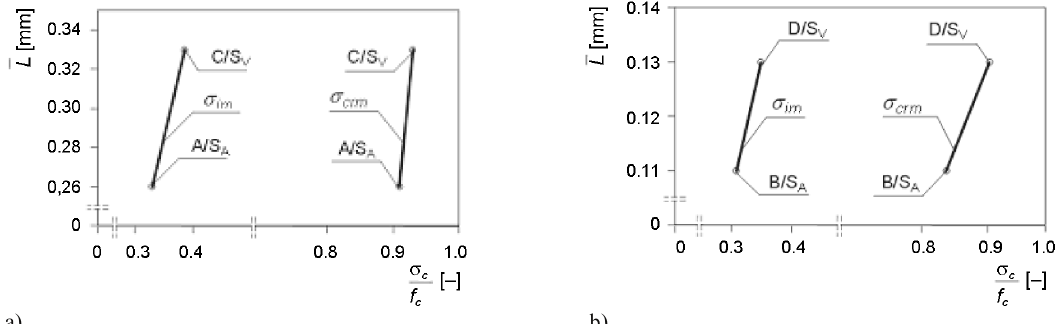
Fig. 14. Dependence of average relative levels of stress σ im and σ crm on air pore distribution index L in hardened self-compacting concrete (pore diameter range 10-4000 μ m): a) A/S A and C/S V , b) B/S A and D/S V